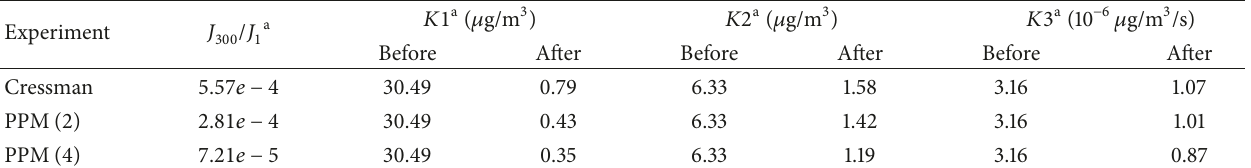
Table 2: The MAEs statistics before and after assimilation, with 55 observation